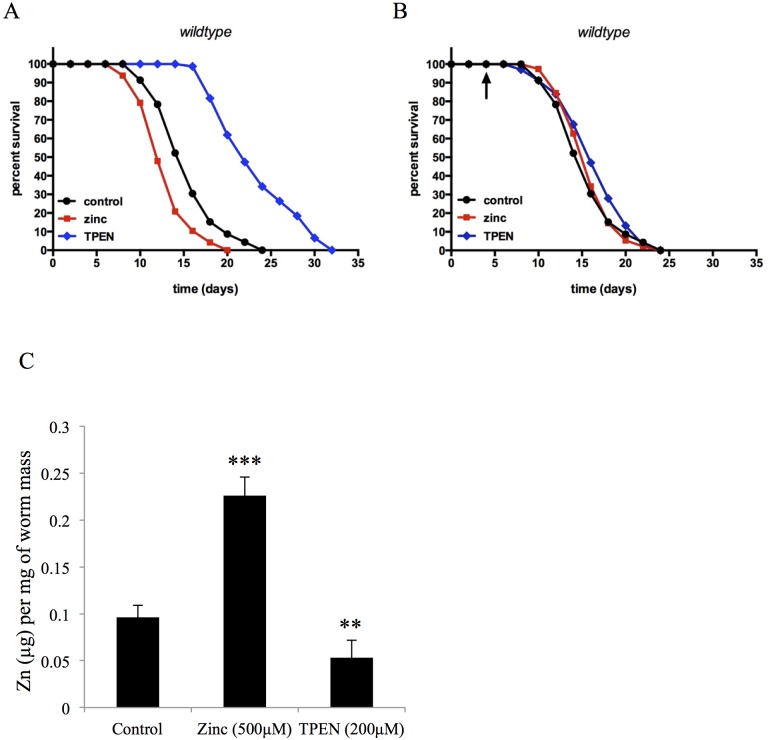
Zinc availability regulates the lifespan of C. elegans.(A) Kaplan-Meier survival curve of worm populations exposed to zinc or TPEN as larvae. Wildtype worms were exposed to 500μM ZnSO4 or 200μM TPEN at the L3 stage. Mean and maximum population lifespan were reduced with zinc and increased with TPEN treatment (p < 0.0001, log rank test) (B) Kaplan-Meier survival curve of worm populations exposed to zinc or TPEN as adults. Wildtype worms were exposed to 500μM ZnSO4 or 200μM TPEN at day 5 of adulthood. There was no significant difference in mean and maximum population lifespan due to zinc or TPEN treatment. (C) Changes in total zinc content in worms exposed to zinc or TPEN as larvae. Wildtype worms were exposed to 500μM ZnSO4 or 200μM TPEN at the L3 stage and collected at one-day old adult animals for analysis of total zinc content. Worms supplemented with zinc had a ~2-fold increase in total zinc content (***, p<0.0001, t-test), while worms treated with TPEN demonstrated a ~2-fold decrease in total zinc content (**, p<0.001, t-test). Data shown are the mean ± SD of 3 experimental replicates.